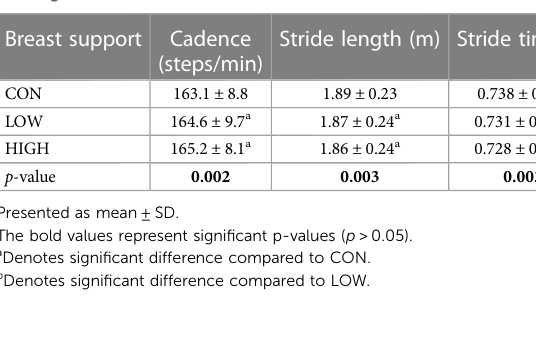
TABLE 2 Effect of breast support on temporospatial characteristics of